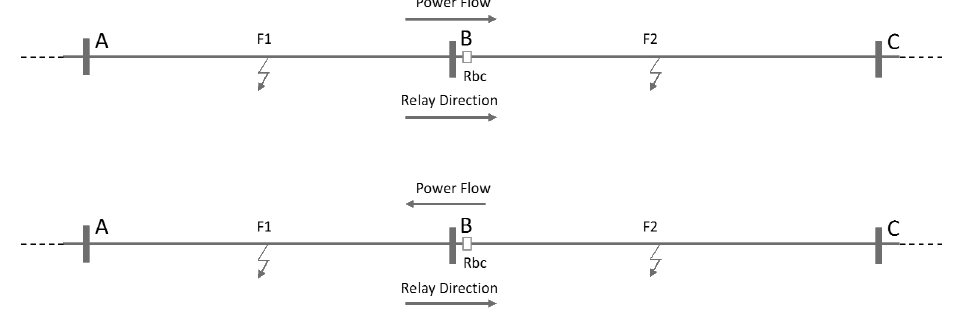
Figure 4. Relay direction vs. power flow direction [63].